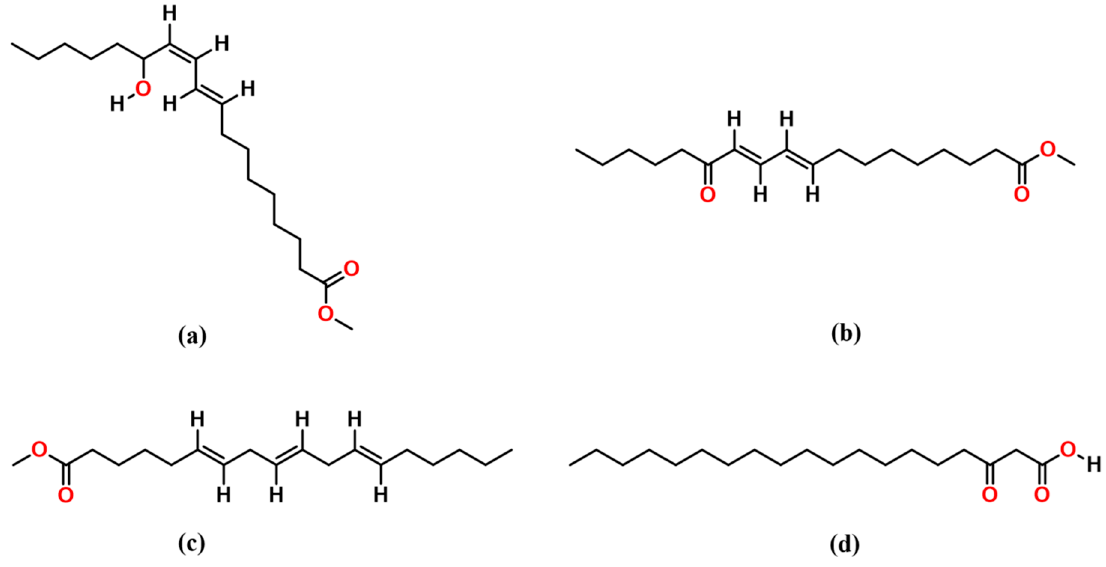
Figure 6. Structure of biosurfactant production of H. meridiana BK-AB4, ( a ) 9(E),11(Z)-Octadecadienoic acid, 13-hydroxy-, methyl ester, ( b ) 9(E),11(E)-Octadecadienoic acid, 13-oxo-, methyl ester, ( c ) 6,9,12-Octadecatrienoic acid, methyl ester, and ( d ) 3-Oxononadecanoic acid.